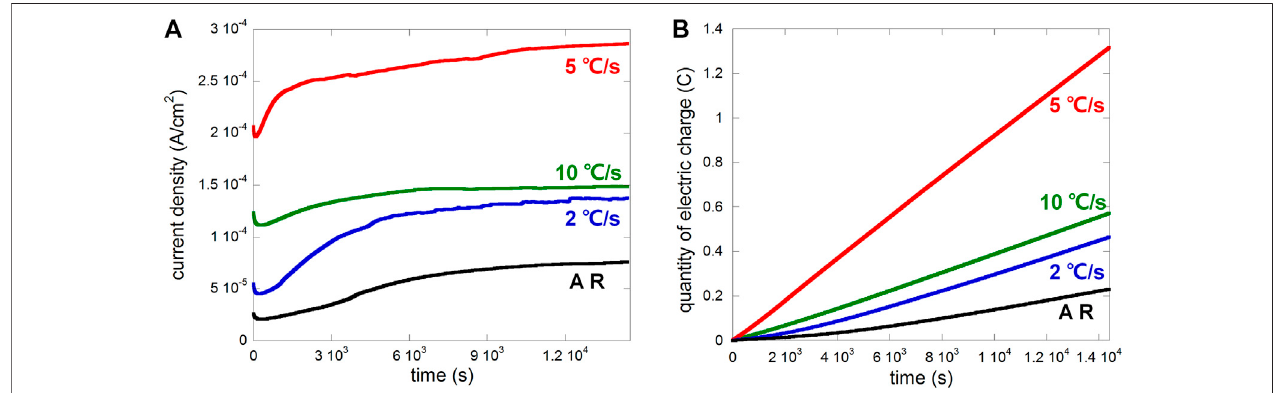
FIGURE 5 | Macrographs of the surface of the as-received sample presenting crevice corrosion development at 0.15 V vs. OCP in 0.1 M NaCl, taken by theself-designed device (lower partshowsupper leftofthe surface).